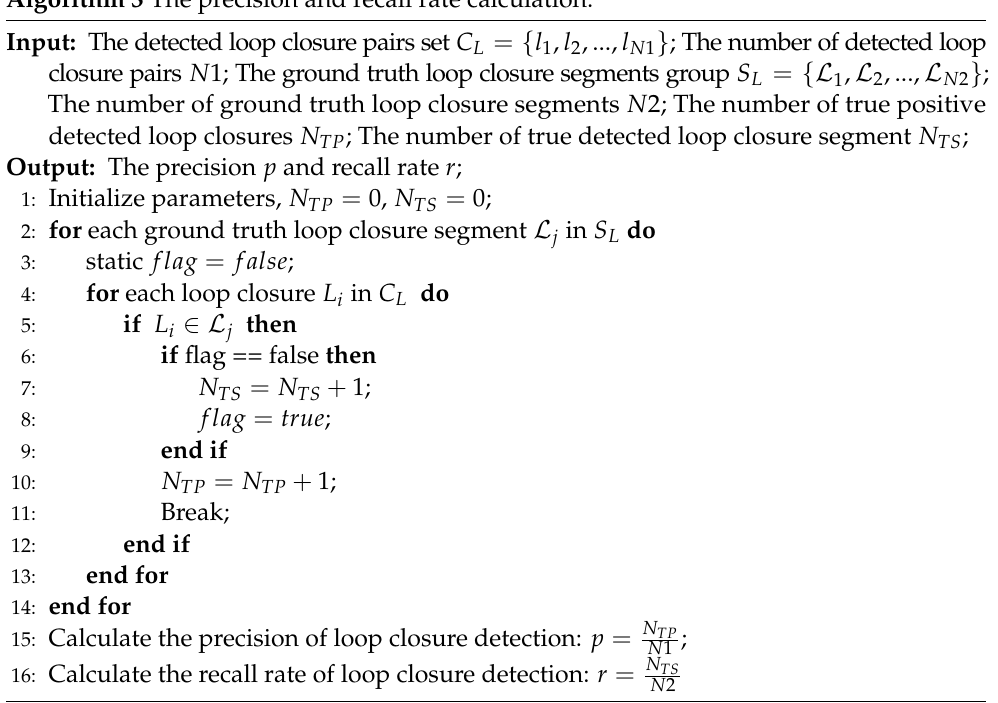
Algorithm 3 The precision and recall rate calculation.